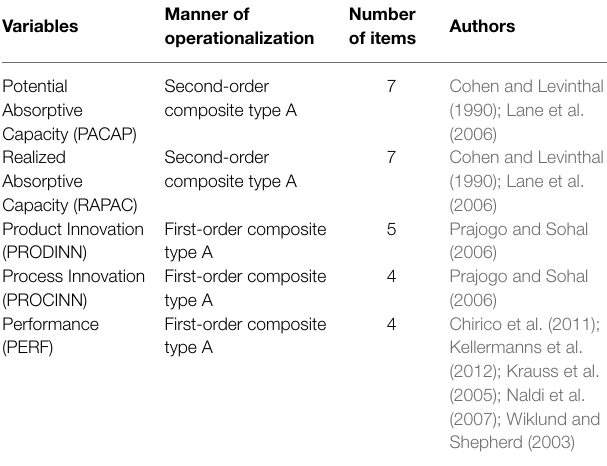
TABLE 3 | Measurement of